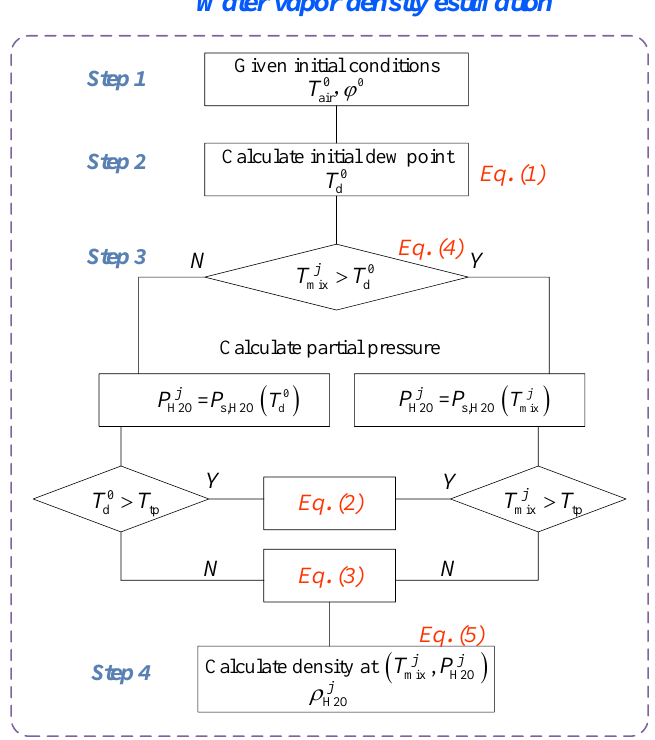
Figure 4. Flowchart of water vapor saturation pressure estimation.